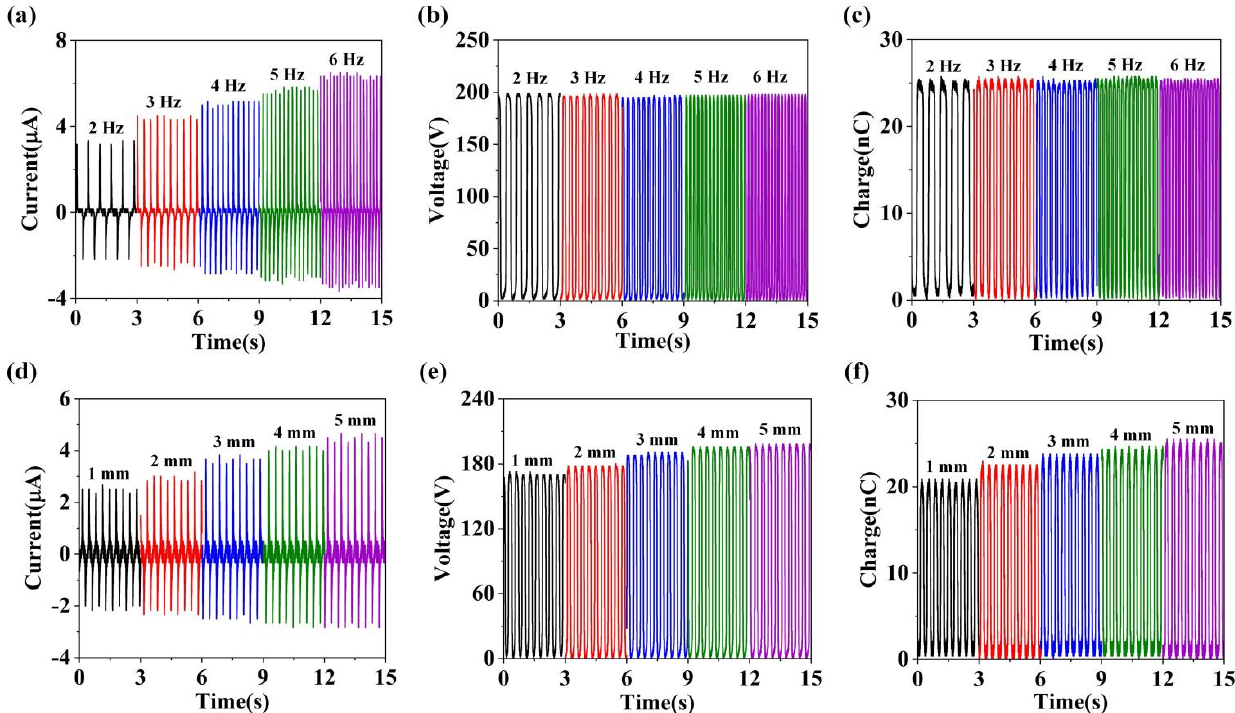
Figure 4. The ( a ) I sc , ( b ) V oc and ( c ) transfer charge of S-TENG under different operating frequencies. The ( d ) I sc , ( e ) V oc and ( f ) transfer charge of S-TENG under different maximum separation distance.